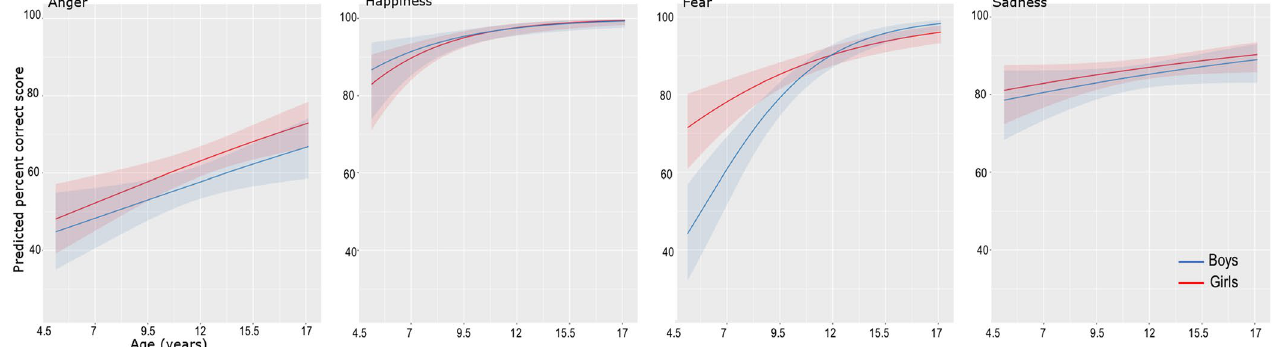
Figure 2. Logistic regression fitted for the four emotions separately. From left to right: Anger, Happiness, Fear and